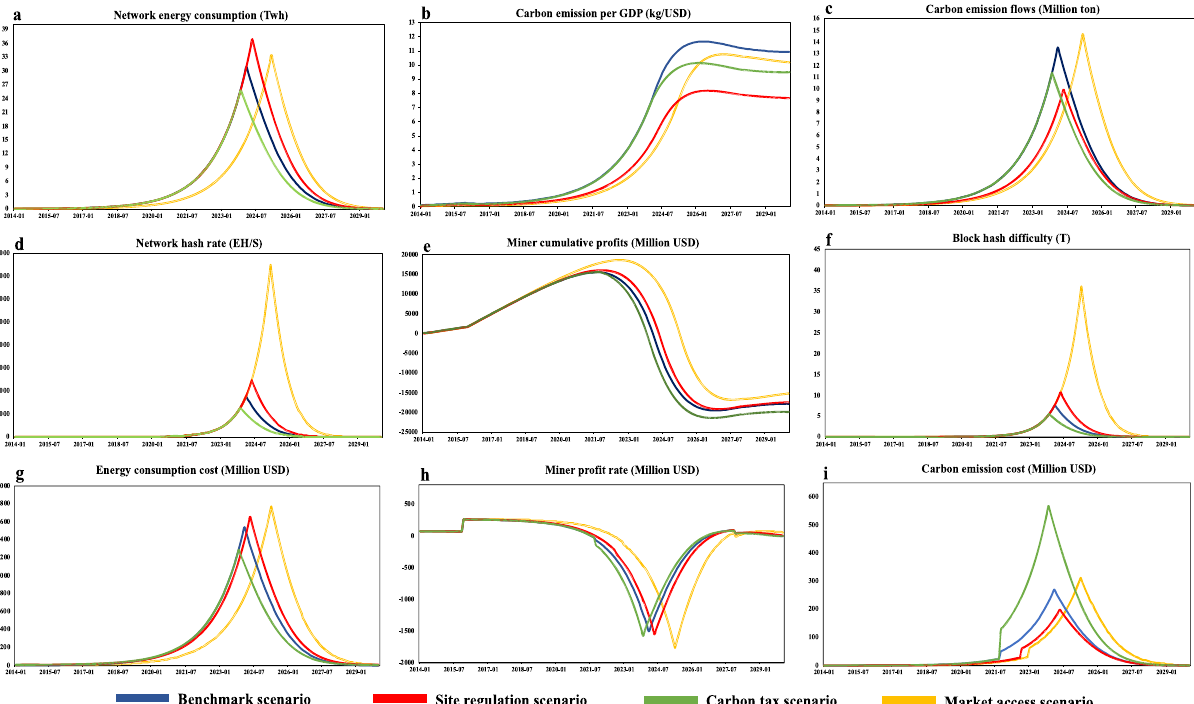
Fig. 4 BBCE scenario assessment comparisons. a – i Monthly network energy consumption ( a ), carbon emission per GDP ( b ), carbon emission fl ows ( c ), network hash rate ( d ), miner cumulative pro fi ts ( e ), block hash dif fi culty ( f ), energy consumption cost ( g ), miner pro fi t rate ( h ), and carbon emission cost ( i ) under each intended policy are simulated and calculated by BBCE framework. Based on the regressed parameters of the BBCE model, the whole sample timesteps of network carbon emission assessment cover the period from January 2014 to January 2030.